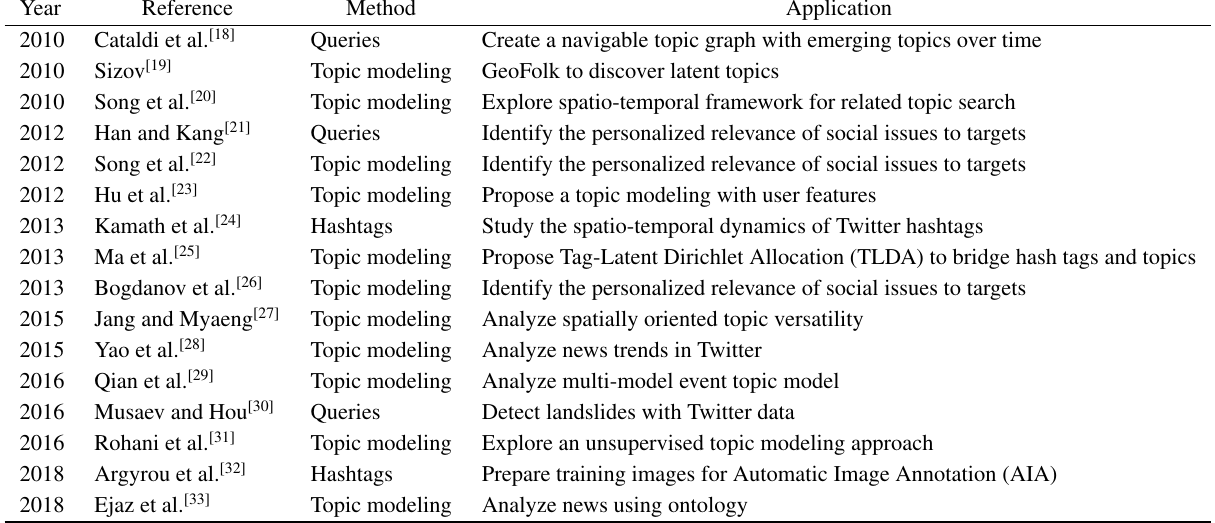
Table 1 Summary of previous works in topic